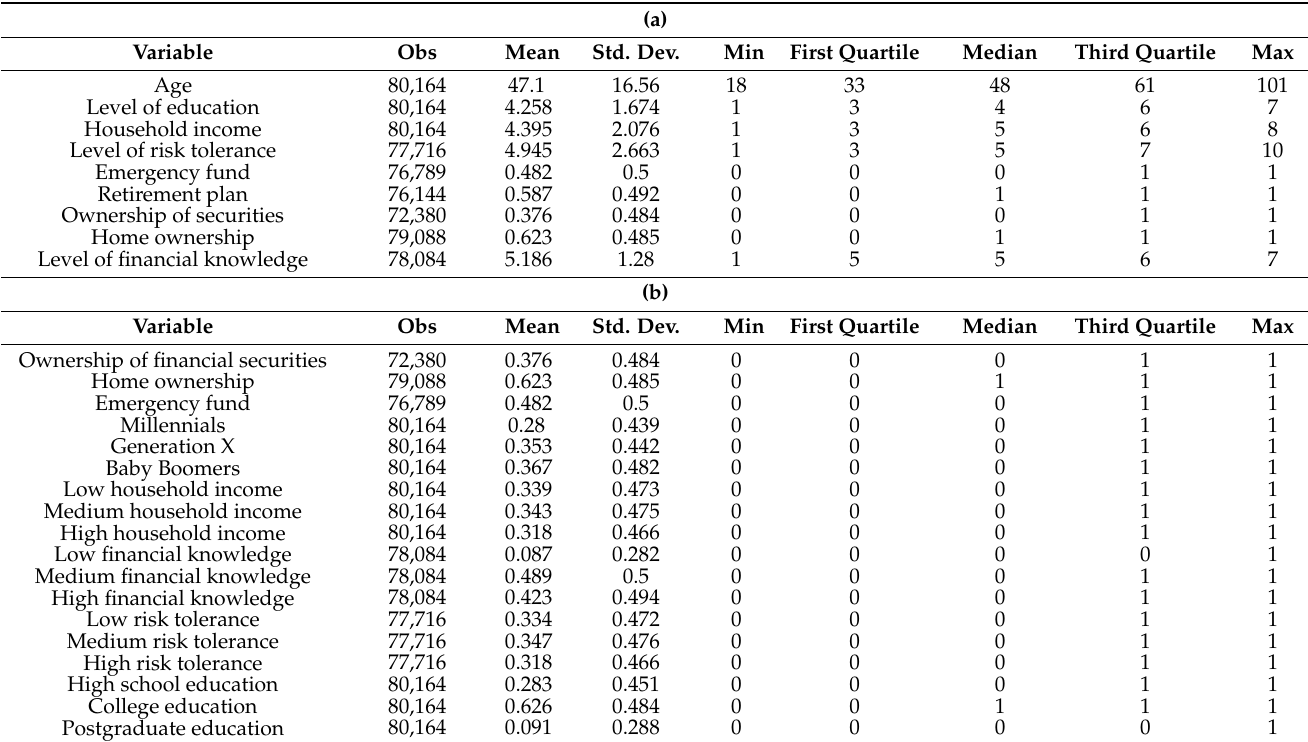
Table 1. ( a ) Descriptive statistics based on the original survey data. ( b ) Descriptive statistics based on the variables